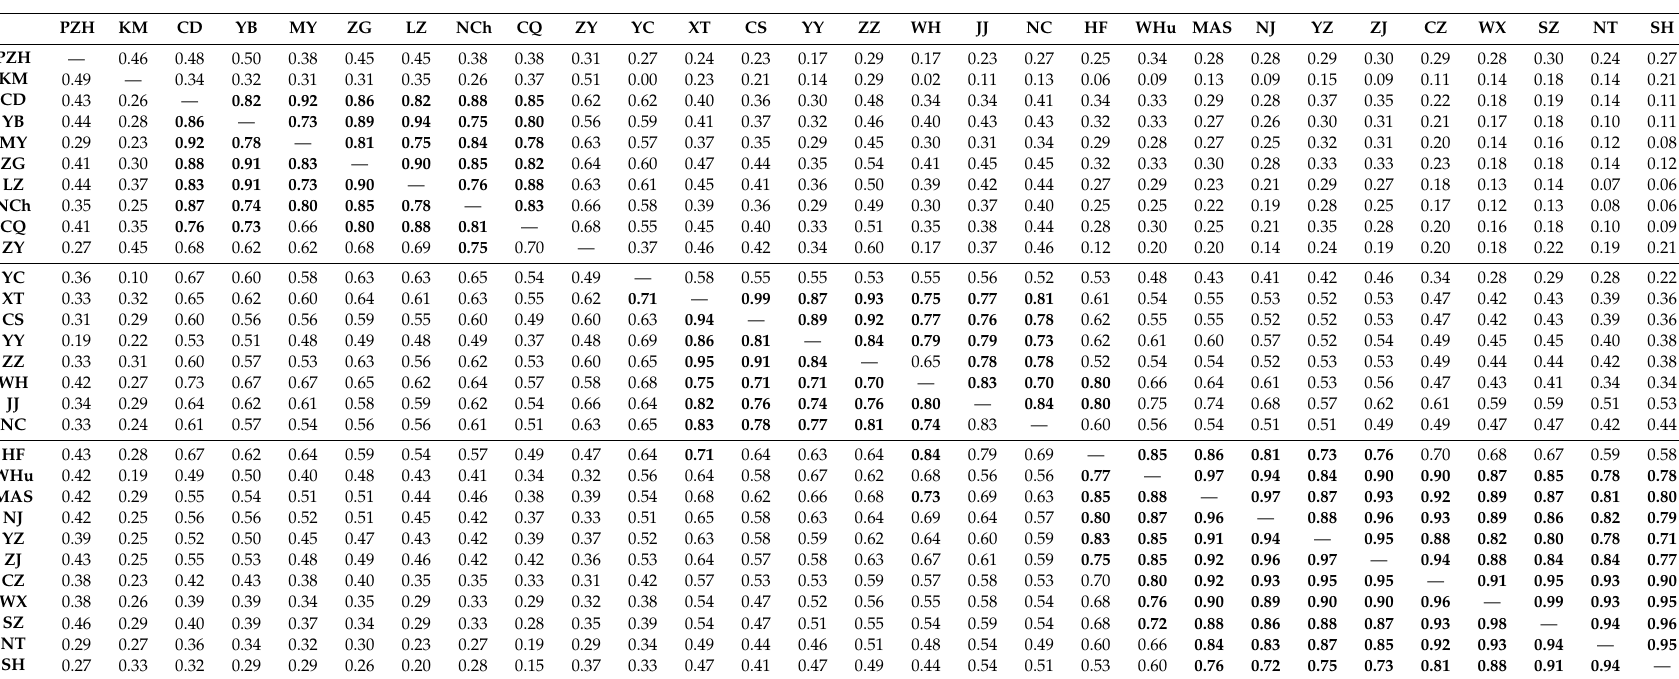
Table 3. Pearson correlation coe ffi cients ( r ) for PM 2.5 (cells above the diagonal) and PM 10 (cells below the diagonal) between studied cities. 0 < r ≤ 0.3 (weak correlation), 0.3 < r ≤ 0.7 (moderate correlation), and 0.7 < r ≤ 1.0 (strong correlation, in